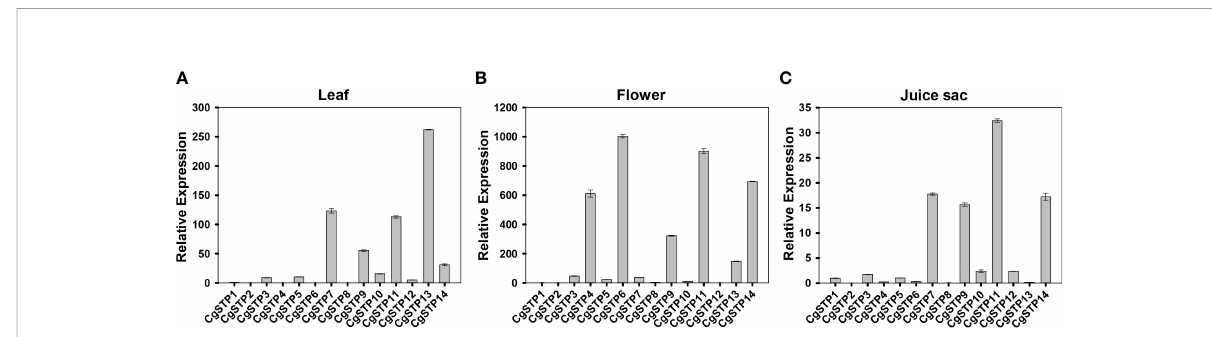
FIGURE 3 Relative expression patterns of CgSTPs in different tissues. (A) Leaf. (B) Flower. (C) Juice sac. The relative expression of all CgSTP members was determined by qRT-PCR assay. The CgActin was de fi ned as the reference and the CgSTP1 ’ s expression level was normalized as 1. Data are mean ± SE